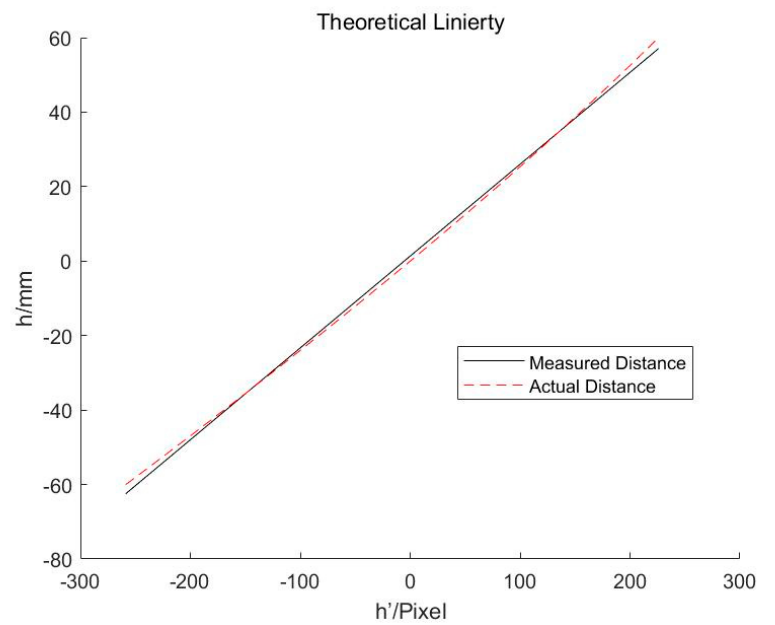
Figure 10. Theoretical linearity of the measurement system.